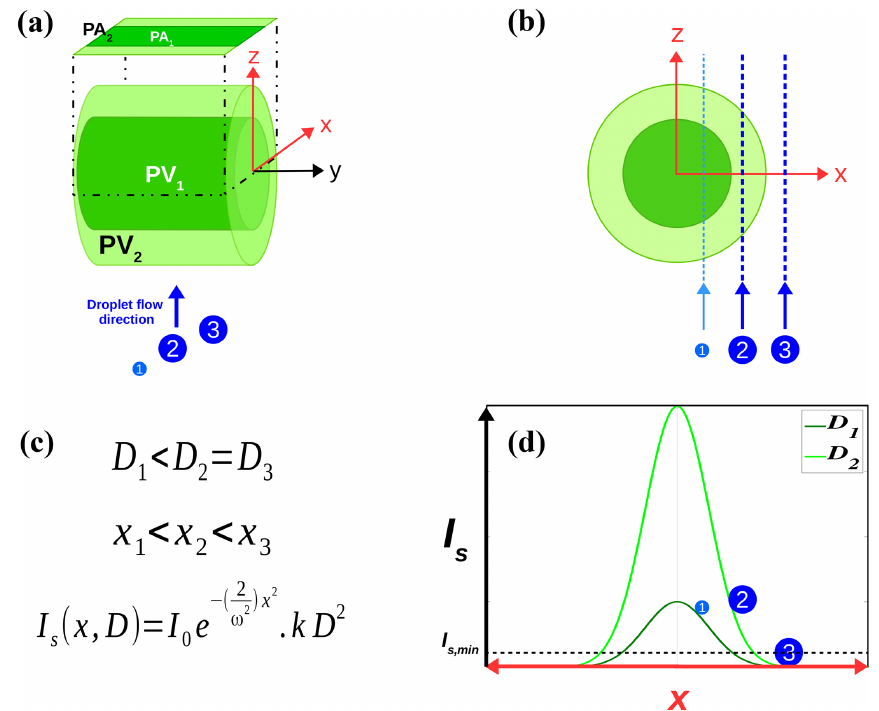
Figure 2. (a) Schematic representation of the cylindrical effective PV and probe area (PA) of the PDI for two different sizes of three passing droplets; (b) side view of panel (a) showing trajectories of the droplets located at different positions ( x ) from the yz plane; (c) relationship between size ( D ) and position ( x ) of the droplets along with the formula of the scattered intensity ( I s ) as a function of x and D (where k is an instrument constant); (d) qualitative graphs of I s − x illustrating the scattered intensity of each droplet based on its x and D as well as the minimum I s below which a droplet cannot be